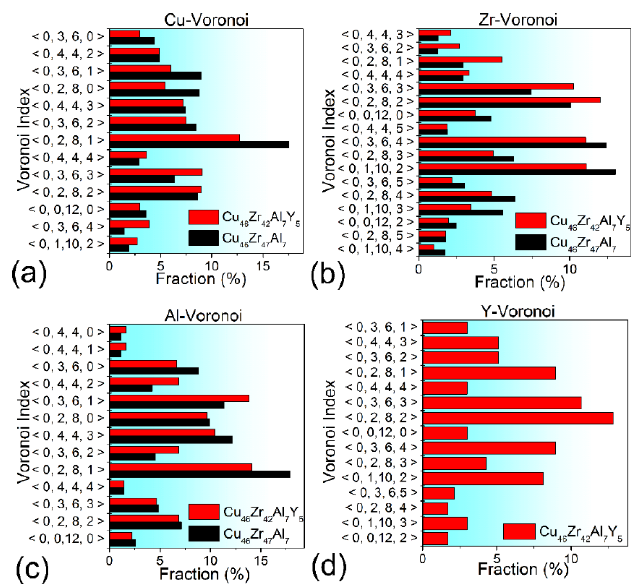
Figure 3. Distribution of the major Voronoi clusters (VCs), including: ( a ) Cu ‐ centered VCs; ( b ) Zr ‐ centered VCs; ( c ) Al ‐ centered VCs; and ( d ) Y ‐ centered VCs. Only those whose fractions are larger than 2% are selected. The CN value denotes the number of shell atoms of the corresponding VC; i.e. , the CN around the center atom.